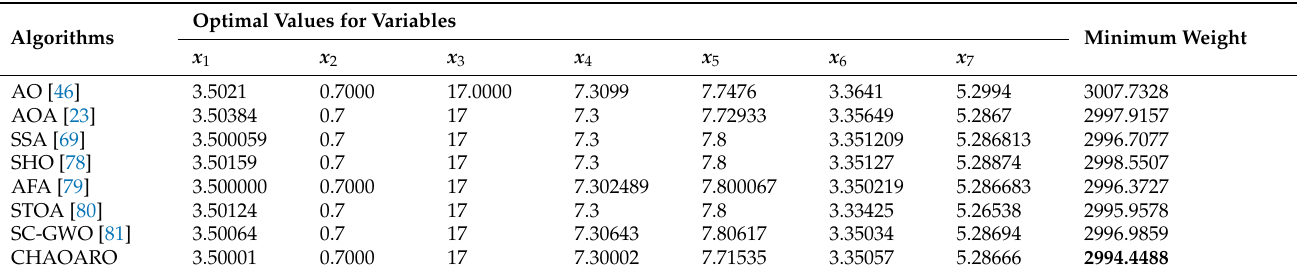
Table 15. Comparison results for speed reducer design